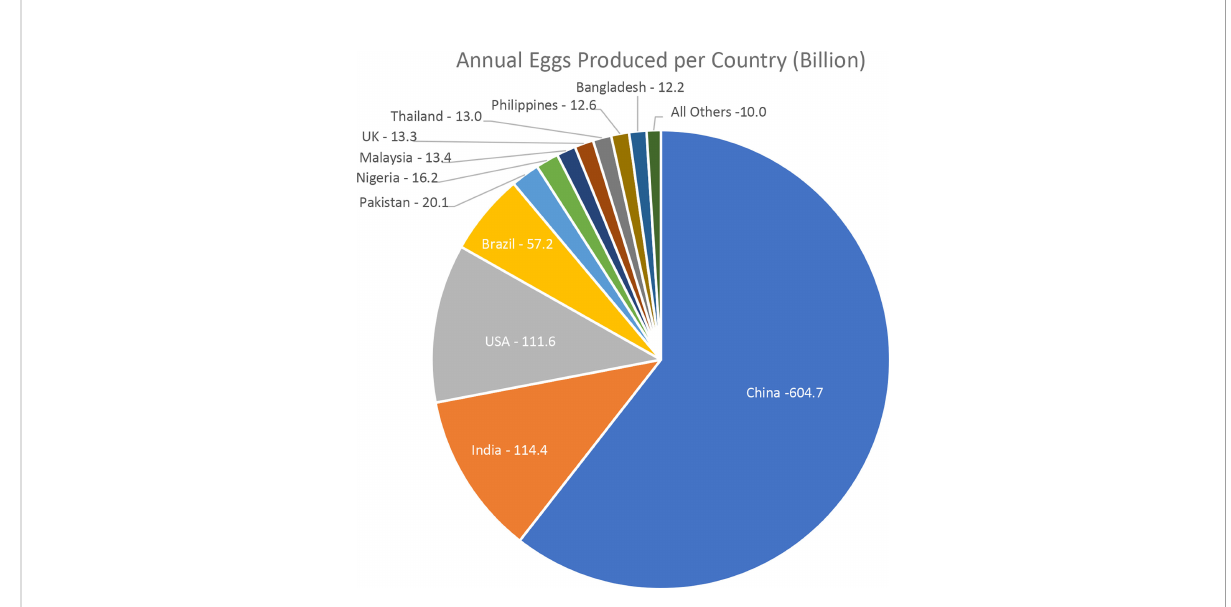
FIGURE 1 Egg production by country, by billion eggs. Data from FAOSTAT (Food and Agriculture Organisation,